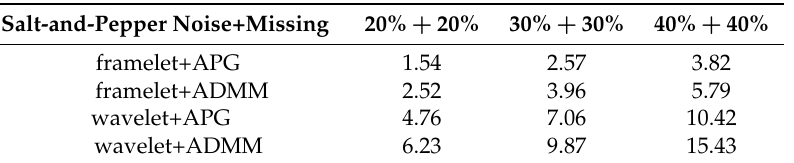
Table 2. Mean absolute errors (MAEs) for the lena image with different levels of salt-and-pepper noise and data missing.